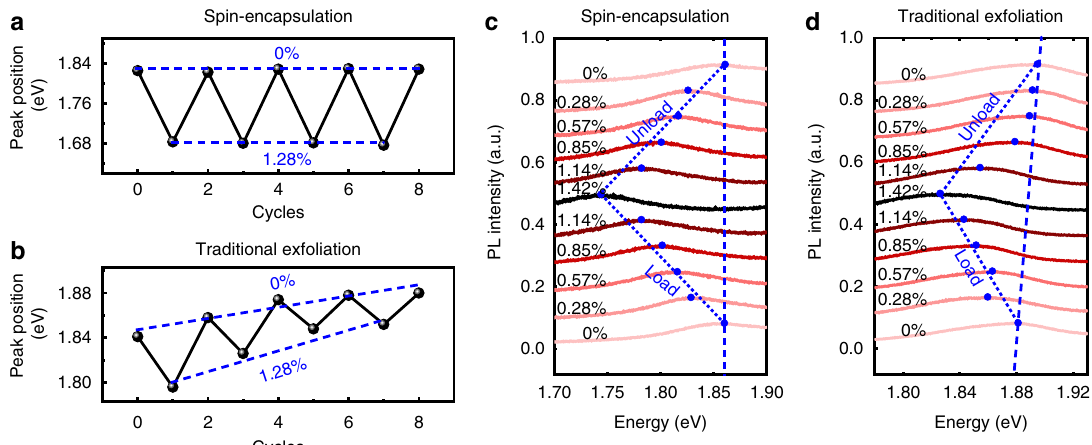
Fig. 3 Multiple cycles straining-relaxing and load-unload bending test. a , b The multiple cycles straining and relaxing at fi xed tension strain of 1.28%, for devices fabricated by our PVA encapsulation method ( a ) and the conventional exfoliating approach ( b ). Within spin-coated PVA approach ( a ), the PL spectrums demonstrate repeatable peak position under multiple cycles test, suggesting the negligible slippage and ef fi cient strain transfer. In contrast, within conventional exfoliating approach ( b ), the PL spectrums demonstrate a much smaller Δ E g and a gradual blue shift with increasing bending cycles, indicating the poor strain transfer and a signi fi cant slippage behavior. c , d The load-unload bending test under variable tension strain level, for our PVA encapsulation method ( c ) and the conventional exfoliating approach ( d ). Within spin-coated PVA approach ( c ), the PL spectrums demonstrate repeatable peak position change, further con fi rming the negligible slippage and ef fi cient strain transfer. In contrast, within conventional exfoliating approach ( d ), the PL spectrums demonstrate much smaller modulation ef fi ciency and blue shift of peak position during unloading process, indicating that the poor strain transfer and a signi fi cant slippage